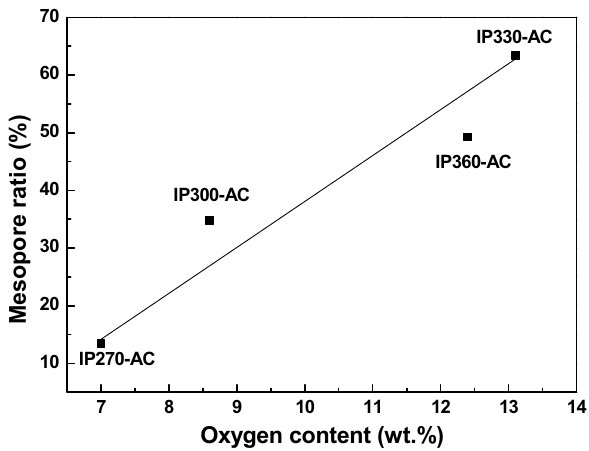
Figure 6. Correlation between oxygen content and mesopore ratio of activated